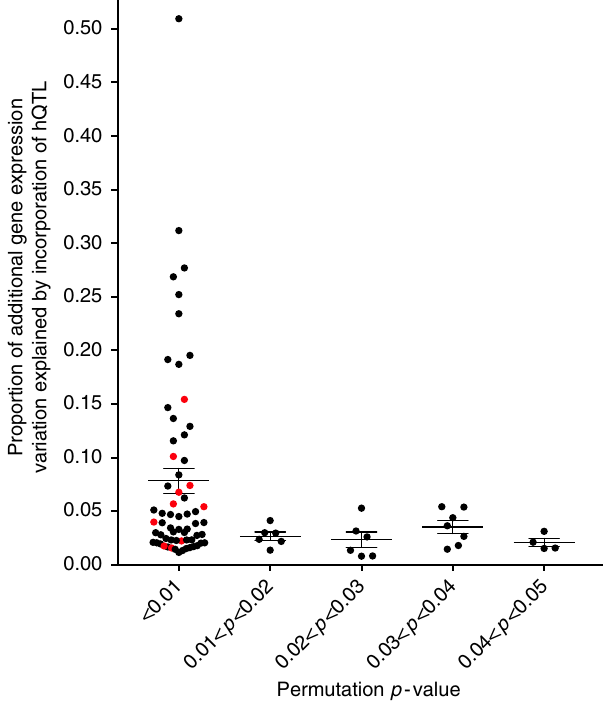
Fig. 2 hQTLs impact gene expression in haplotype blocks that also contain eQTLs. Figure plots the 87 haplotypes for which the hQTL demonstrated signi fi cantly increased ability to model expression variation of the eQTL target gene ( p permutation < 0.05). The proportion of additional gene expression variation by incorporation of the hQTL genotypes ( D 2 ) is plotted on the y -axis and the permutation p -value is plotted on the x -axis. HLA haplotypes are colored in red and non-HLA haplotypes are in